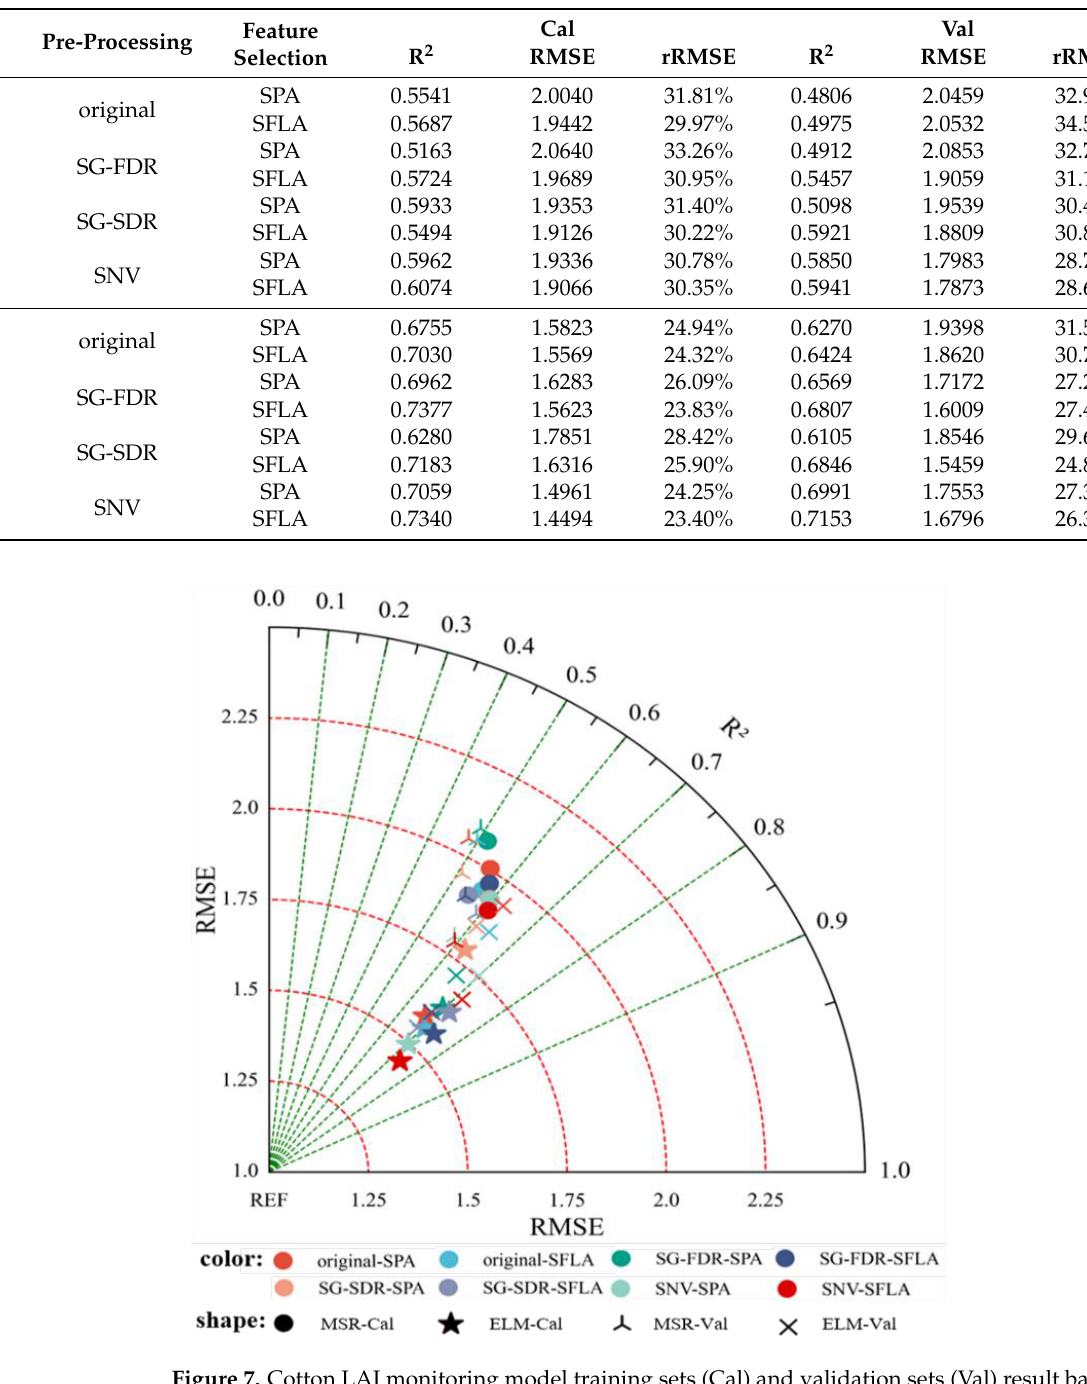
Table 6. Cotton LAI monitoring model training sets (Cal) and validation sets (Val) result based on spectral reflectance.